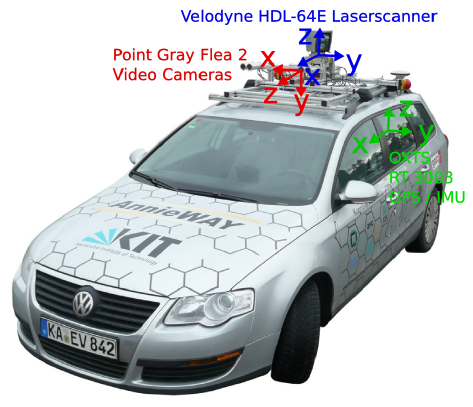
Figure 2: Sensor configuration in KITTI